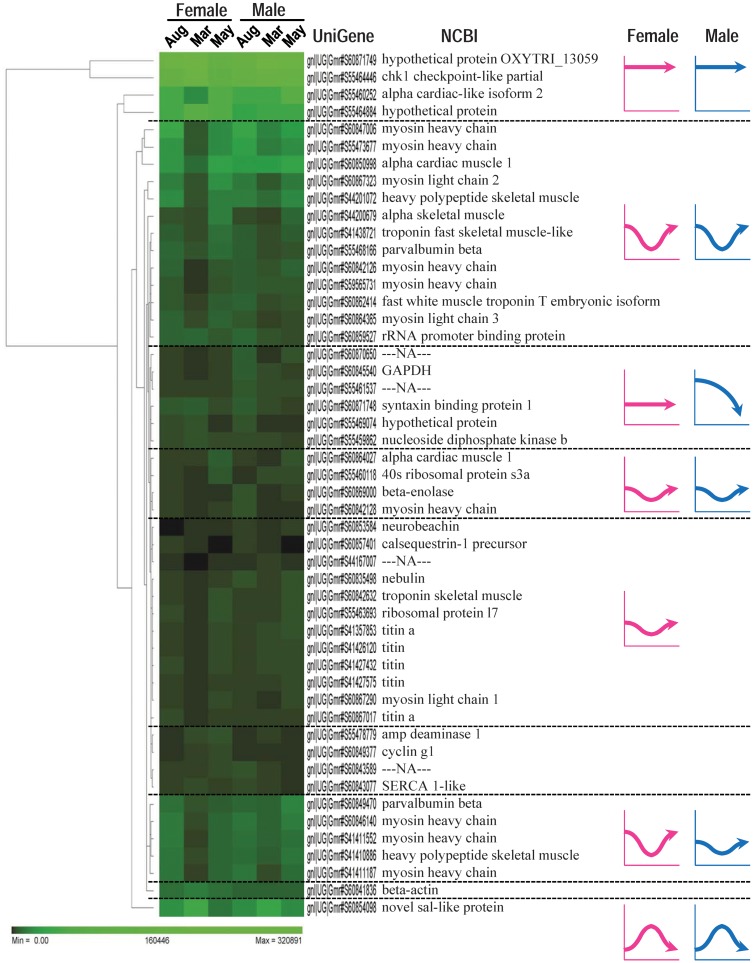
Heat map of the top 50 highly expressed genes.The map contains 50 rows and 6 columns corresponding to the top 50 highly expressed genes and sampling points for both sexes, respectively. All 50 genes have individual UniGene accession numbers and their common gene name registered in NCBI. Several UniGenes (e.g., myosin heavy chain and titin) share the same common gene name but are referred to as individual isoforms, as long as they have unique UniGene accession numbers. Typical clusters containing genes that show similar expression patterns are separated by a dashed line and their expression patterns throughout the year are summarised with arrow graphs for both females (pink arrows) and males (blue arrows).